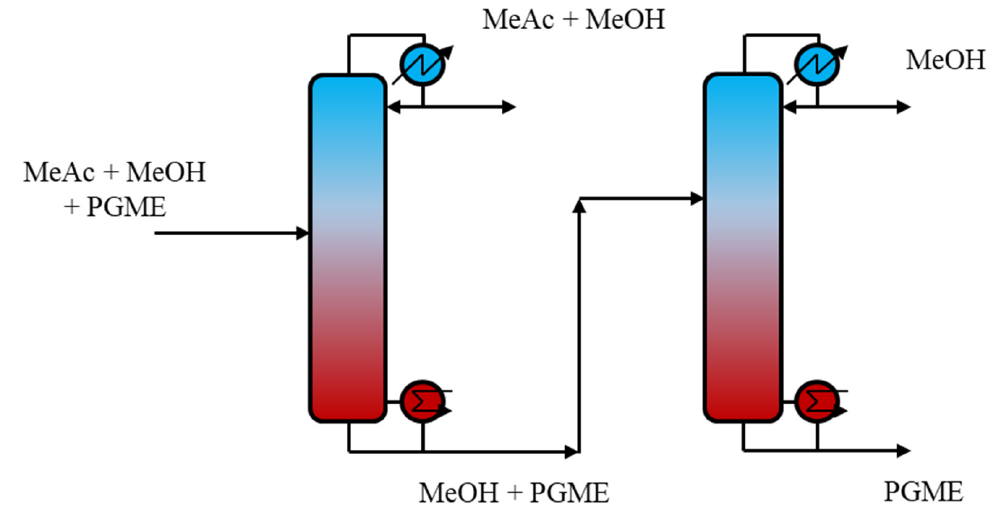
Figure 3. Concept sequence where MeOH as the middle BP fraction is the major component.